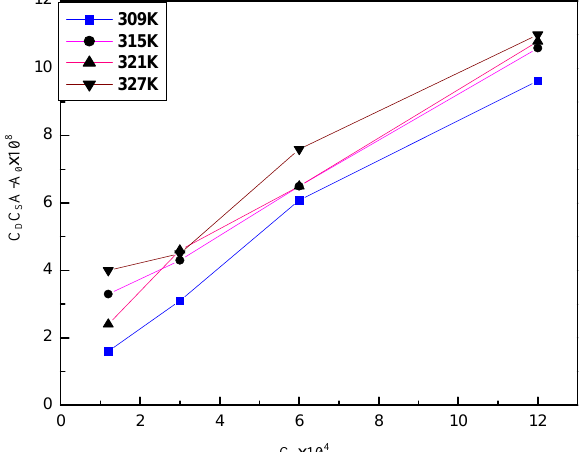
Figure 17. Plots of C